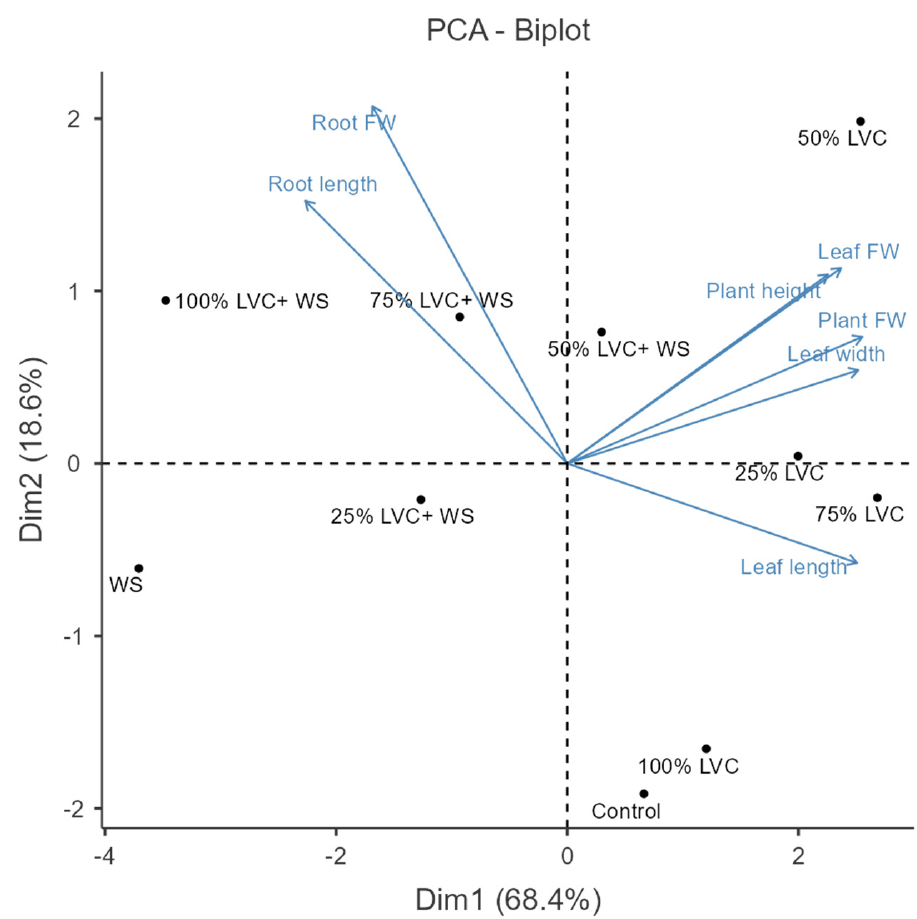
Figure 3. Principal component analysis of agronomic attributes corresponding to the treatments.